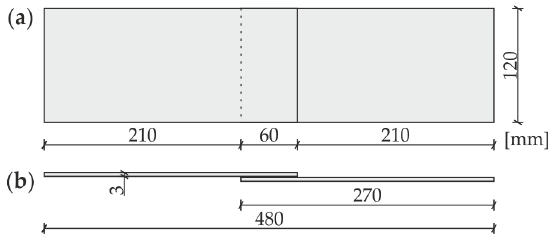
Figure 1. Geometry of investigated specimen: ( a ) plane view; ( b ) side view.